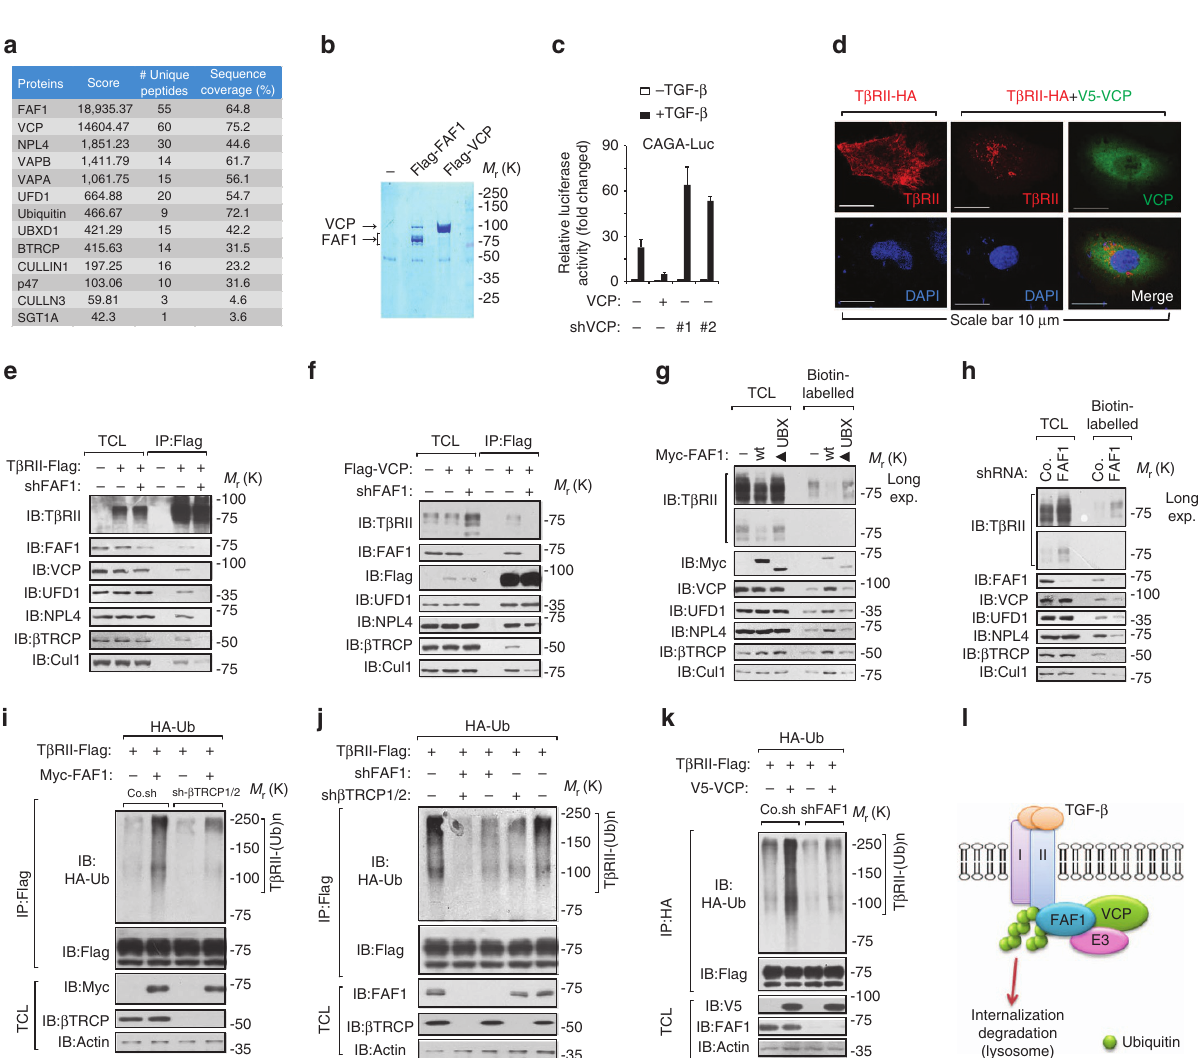
FAF1 correlates with good prognosis in breast cancer patients . Epithelial-like breast cancer cells can undergo epithelial-to- mesenchymal transition (EMT), upon which they become more migratory, invasive and metastatic 26–28 . The upregulation of mesenchymal markers N-cadherin, fibronectin, smooth muscle actin and vimentin, and the downregulation of epithelial marker E-cadherin are typical characteristics of EMT. Gene set enrichment analysis (GSEA) of the NKI breast cancer patients data set 29 demonstrated that gene signatures representing a good prognosis or less invasiveness of the tumour were significantly enriched in patients with higher levels of FAF1 expression